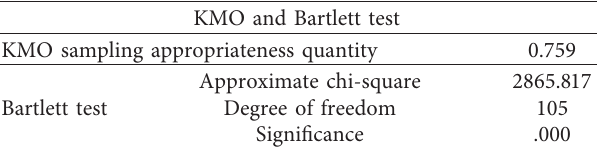
Table 7: KMO and Bartlett’s tests.